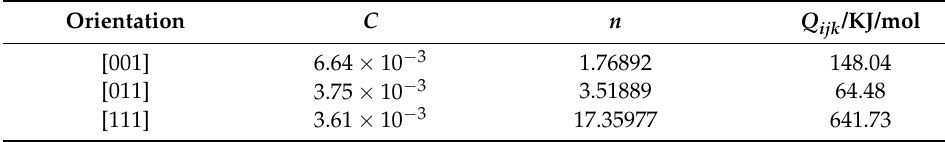
Table 3. Creep strain rate equation parameter fitting results.